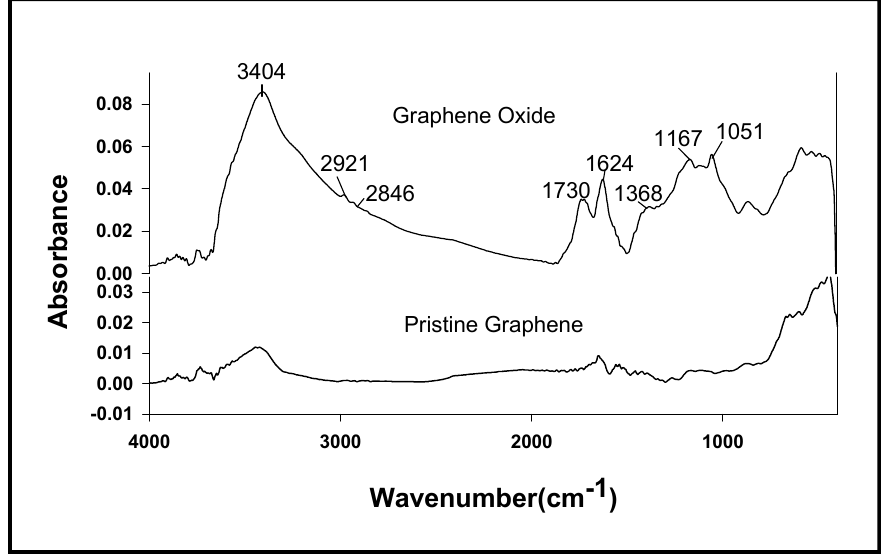
Figure 1. FTIR Spectra of the Pristine Gr and GrO.